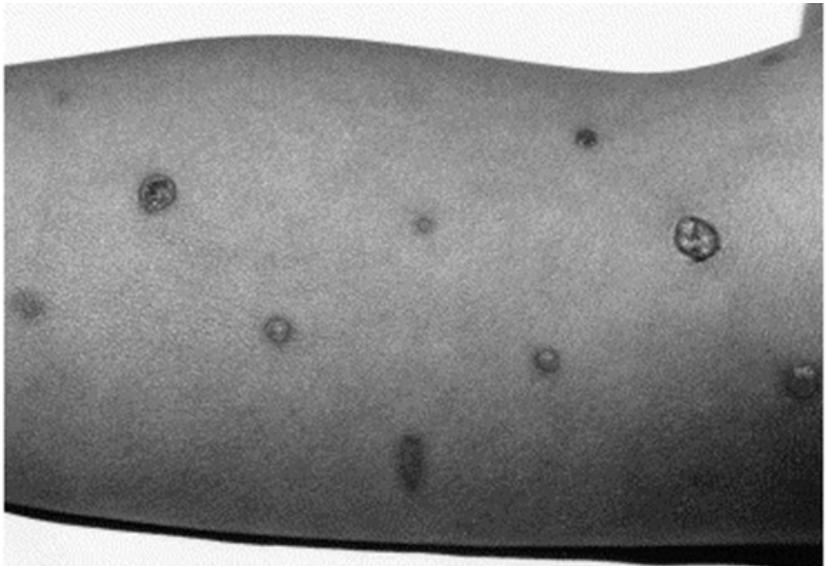
Figure 6. Second-degree burn of a 3-year-old boy after complex cardiac surgery with critically reduced peripheral perfusion. Reproduced from Truell KD, Bakerman PR, Teodori MF, Maze A. Third-degree burns to intraoperative use of a Bair Hugger warming device. Ann Thorac Surg 200; 69: 1933–1934 with permission of Elsevier [100].